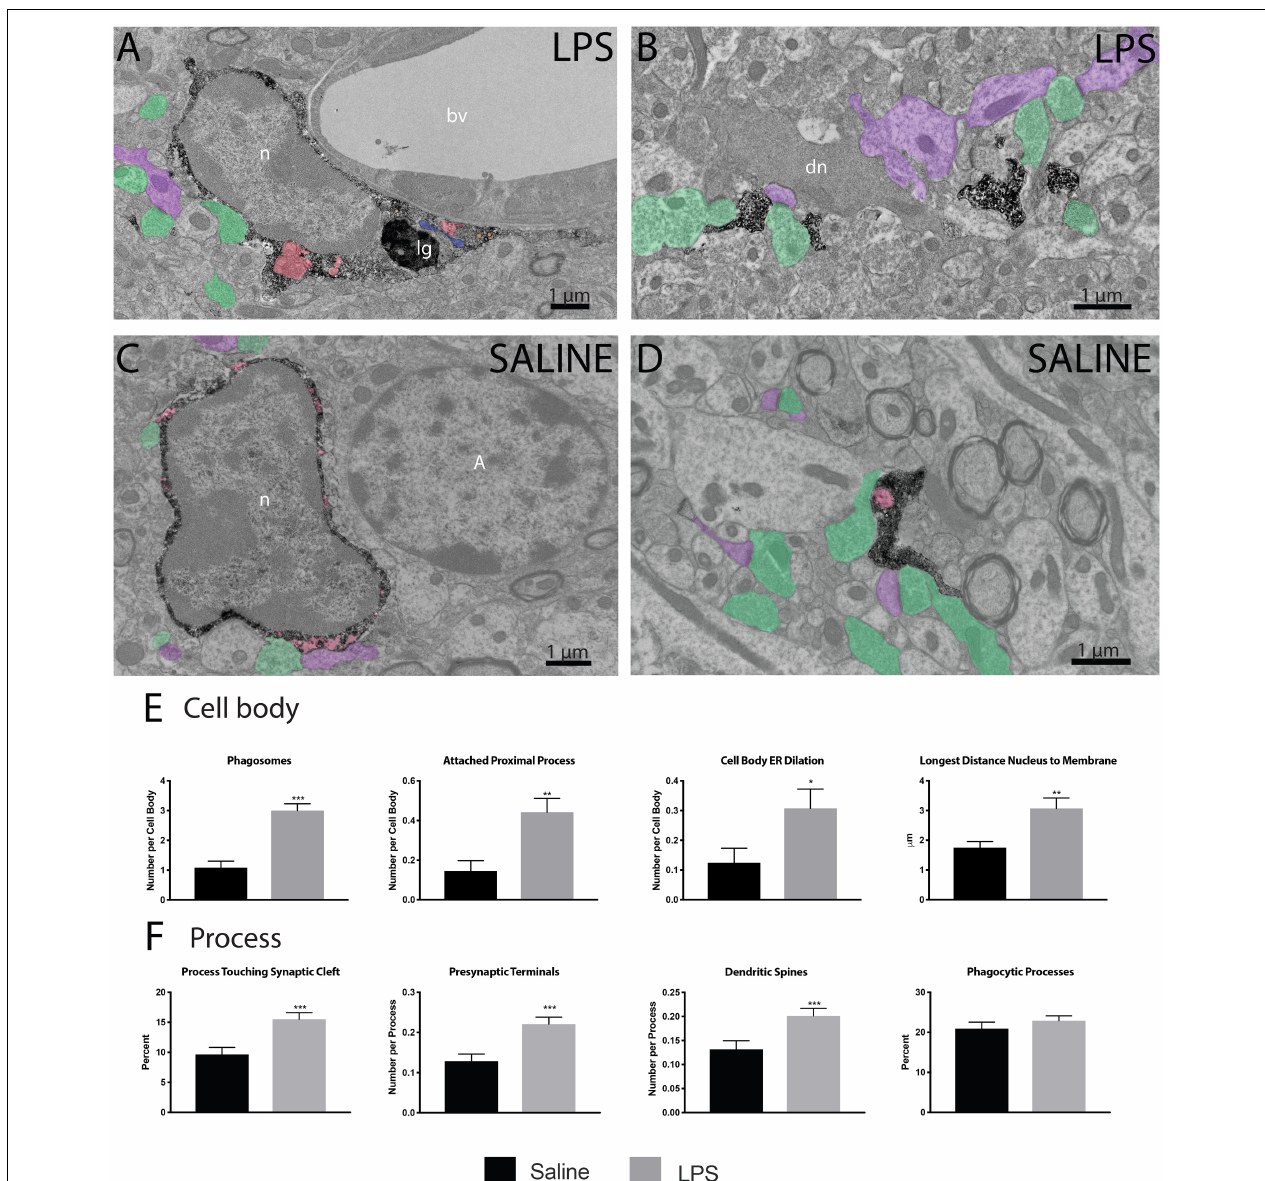
FIGURE 2 | LPS induced variations in microglial ultrastructure. Microglial cell bodies (A,B) and processes (C,D) within the strata radiatum and lacunosum-moleculare region of CA1 hippocampus were stained with anti-IBA1 antibody and investigated using transmission electron microscopy. Microglial cell bodies in LPS treated animals often contained long processes connected to their cell bodies, numerous lipidic (lg) and phagocytic inclusions (red) as well as dilated endoplasmic reticulum (ER; blue). Microglial processes often contacted asymmetric synapses including presynaptic terminals (green) and postsynaptic dendritic spines and shafts (purple). In panel (B) , a dark dendrite is also seen extending a dark spine that receives a synaptic contact from a healthy-looking axon terminal. The interaction of microglial cell bodies (E) was quantified, including number of phagosomes, attached proximal processes, and number of dilated ER stretches per cell body, as well as the longest distance between the cell body and nucleus. The interaction of microglial processes (F) with the neuropil was also quantified, including interactions with synaptic structures comprising synaptic clefts, presynaptic terminals and postsynaptic dendritic spines. ∗ p < 0.05, ∗∗ p <